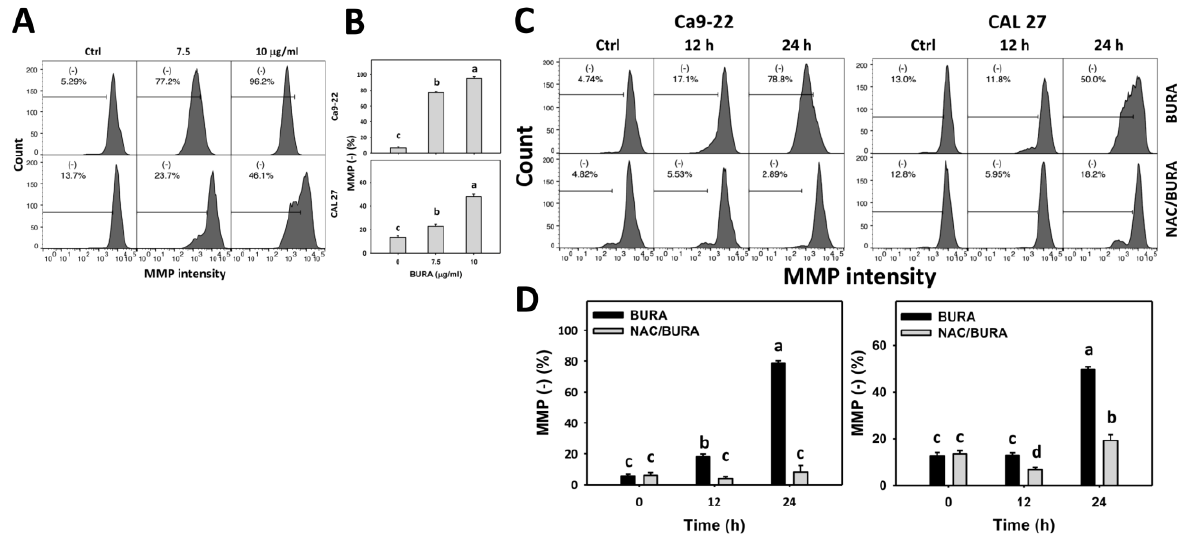
Figure 7. BURA causes MMP reduction in oral cancer cells. ( A , B ) MMP patterns and quantification. Oral cancer cells (Ca9-22 and CAL 27) were treated with BURA (control (0.1% DMSO), 7.5 μg /mL (25.3 μM), and 10 μg /mL (33.8 μM), 24 h). (− ) located within the patterns represent MMP ( − ). ( C , D ) NAC effect on MMP pattern and quantification. After NAC treatment (10 mM, 1 h), cells were treated with BURA (10 μg /mL) for 0 (control), 12 and 24 h. Data, mean ± SD ( n = 3). Data top-labeled with non-overlapping lower-case letters differ significantly for multi-comparisons ( p < 0.05).